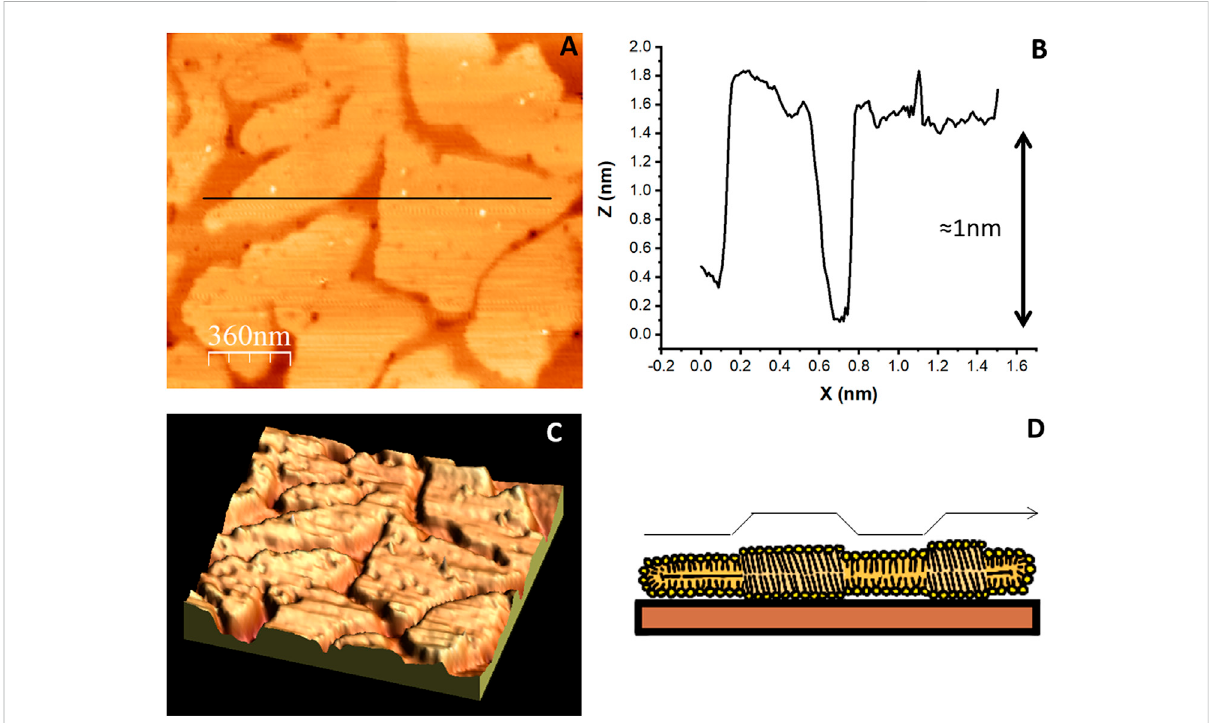
FIGURE 7 AFMtopographicimageofanSLBmadeofamixtureoflipids. (A) SLBcomposedofDPPC45%DLPC18%Bsitosterol8%PIP24%thatsegregate into liquid ordered and liquid disordered domains (Velez et al., unpublished results). The colors represent differences in height: lighter regions protrude from the surface more than darker regions (B) The pro fi le under the black line in (A) shows the 1 nm height of the ordered domains. (C) Threedimensionalrepresentationoftheimagein (A) . (D) illustrationofthelipidarrangementoriginatingtheheightdifferencebetweenordered and disordered